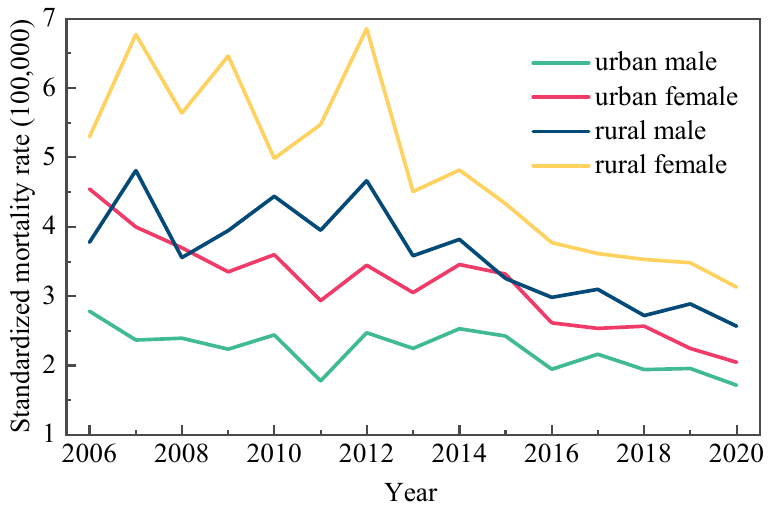
Figure 1. Changes in the standardized mortality rate of RHD in urban and rural areas by sex in China (1/100,000).